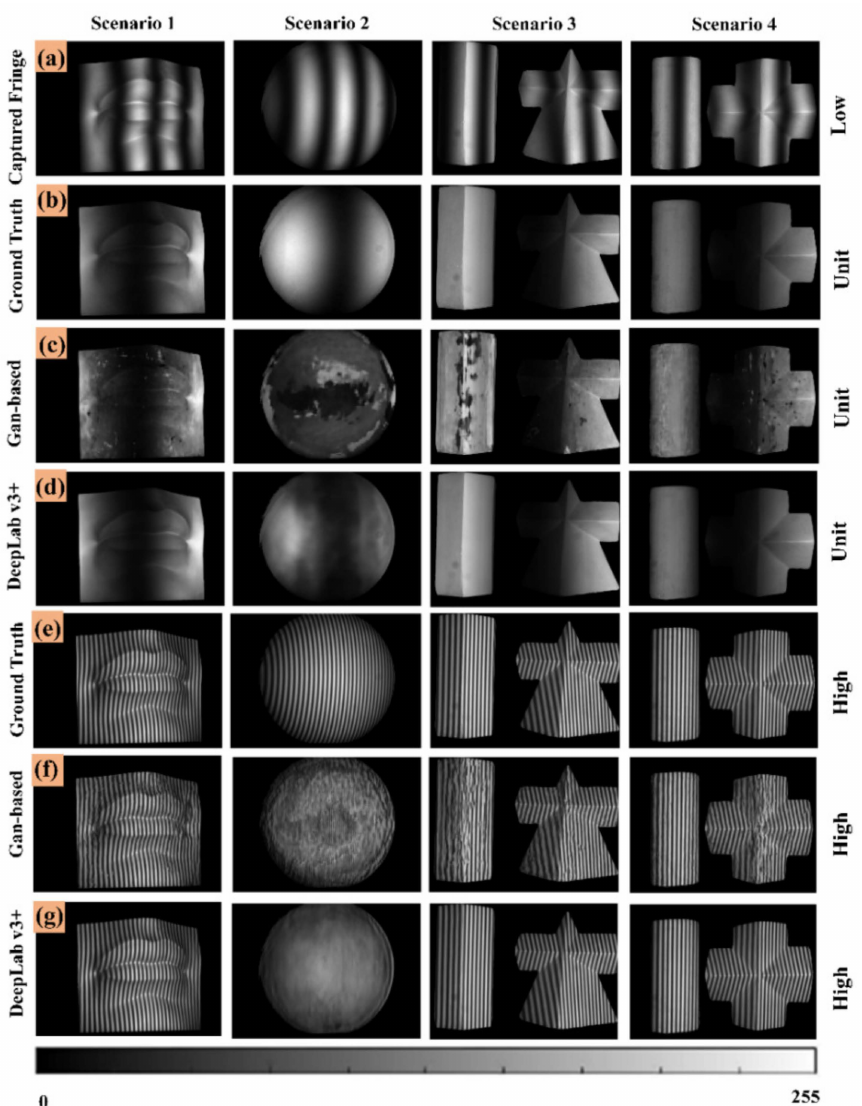
Figure 10. Fringe images generated by different network architectures. ( a ) Captured low-frequency fringe images. ( b ) Ground truths (unit-frequency). ( c ) Unit-frequency fringe images generated by the Gan-based network. ( d ) Unit-frequency fringe images generated by the DeepLabv3+ network. ( e ) Ground truths (high-frequency). ( f ) High-frequency fringe images generated by the Gan-based network. ( g ) High-frequency fringe images generated by the DeepLabv3+